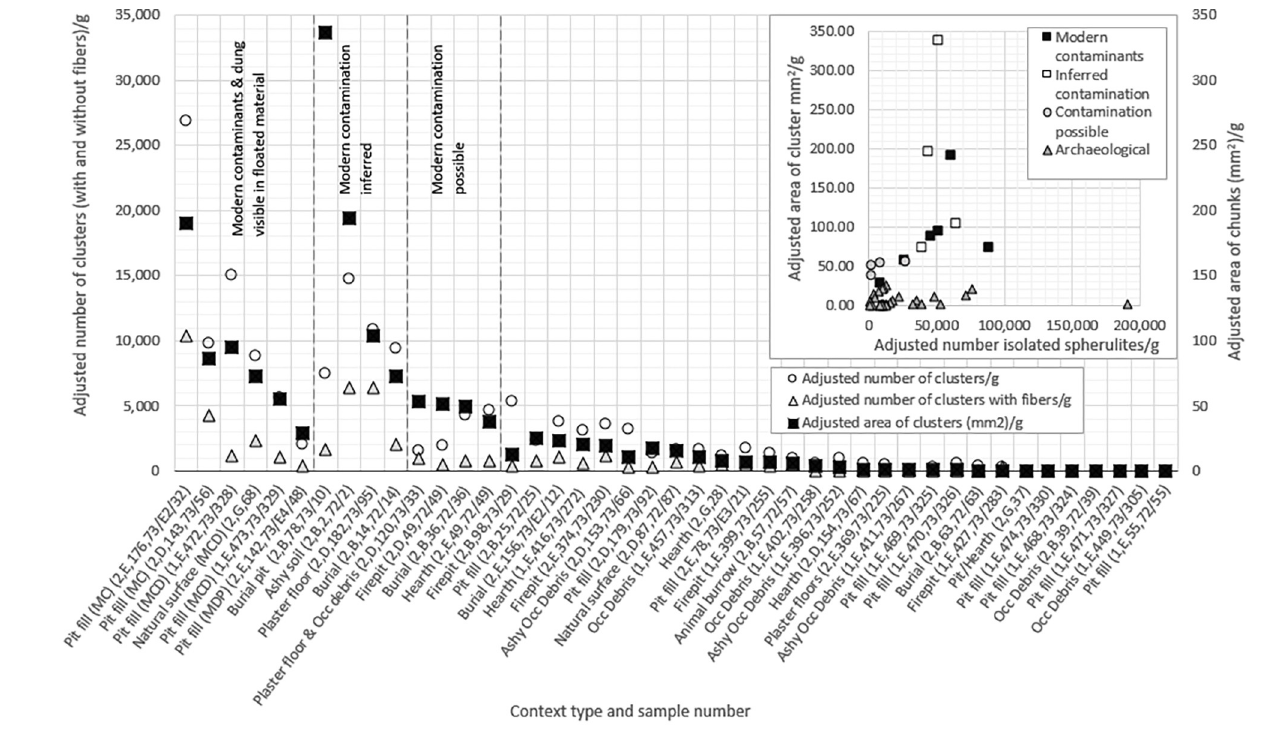
Fig 4. Scatter plot illustrating adjusted number and area of dung spherulite clusters within samples, highlighting samples with visible modern contaminants (MC), visible modern contaminants and dung (MCD), and samples with inferred or possible modern contamination. Inset: Scatterplot highlighting relationship between the isolated number of spherulites/g and the area of clusters mm 2 /g for contaminated, inferred contaminated and uncontaminated samples. No correlation between x and y variables: y = 0.0005 x + 23.554, R 2 = 0.0633.